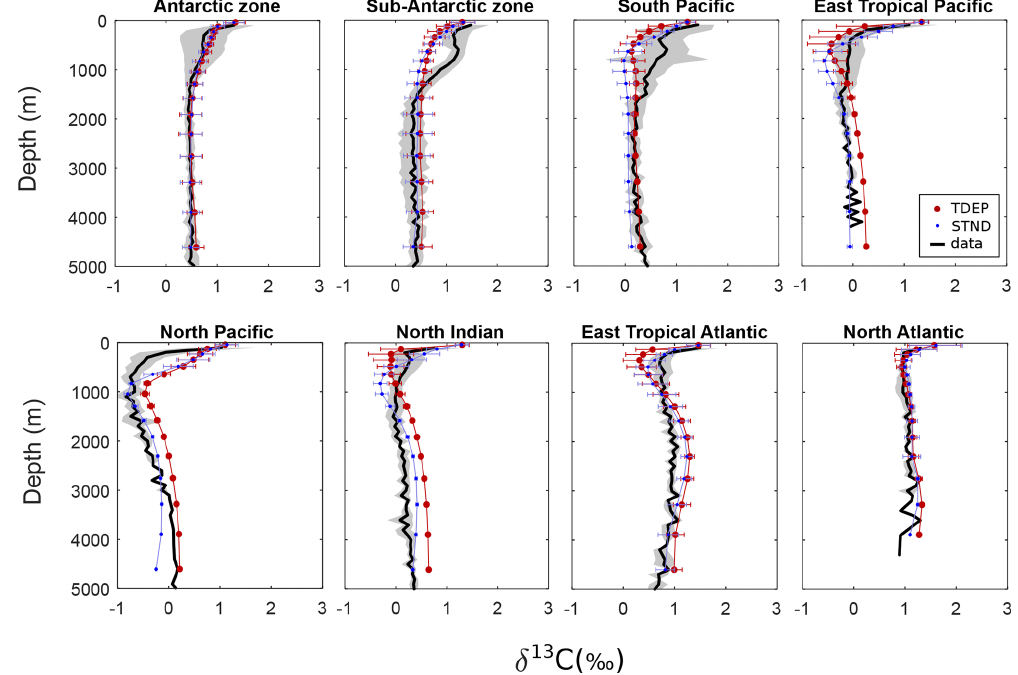
Figure 10. δ 13 C of DIC (‰ VPDB) per depth by region for the model and data (mean and standard deviation). Data from Schmittner et al. (2013). STND is the standard model, and TDEP is the temperature-dependent model.